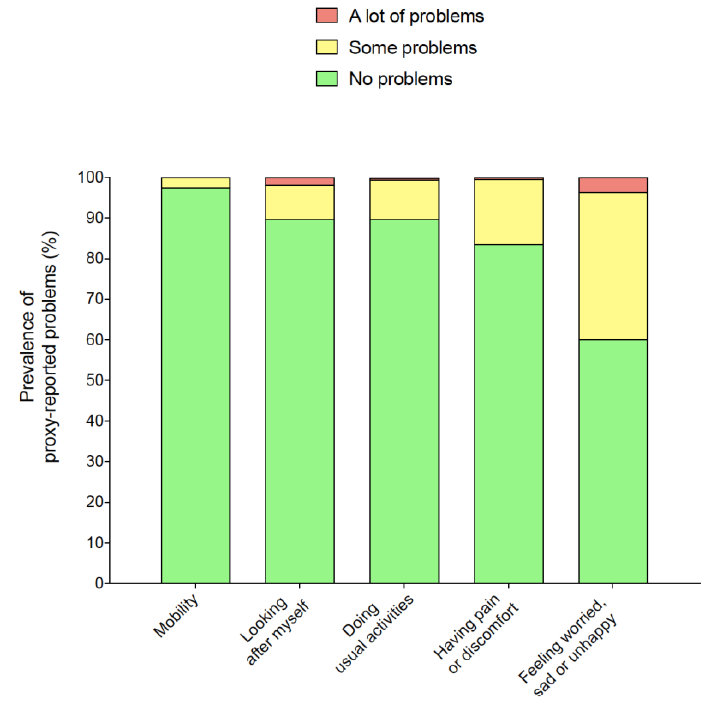
Figure 1. Distribution of proxy-reported problems in relation to the five different HRQoL dimensions in the analysed sample.